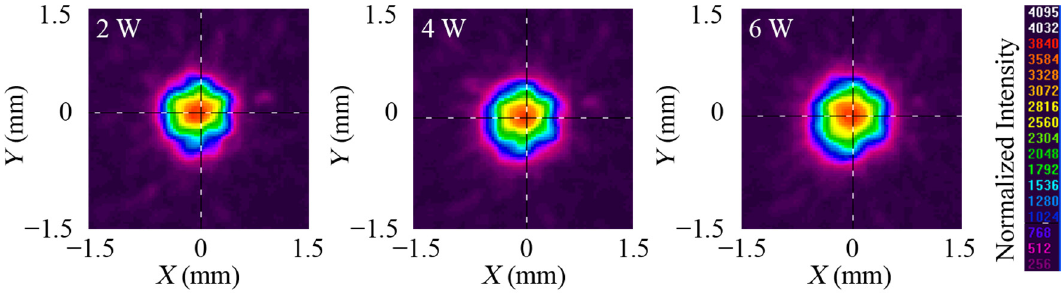
Figure 9. Variation in the coupled spots at output seed powers of 2 W, 4 W and 6